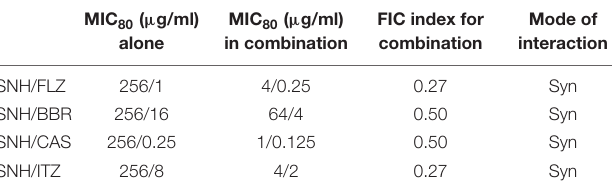
TABLE 2 | Interaction of SNH and antifungals against C. albicans SC5314 by MIC 80 of checkerboard microdilution